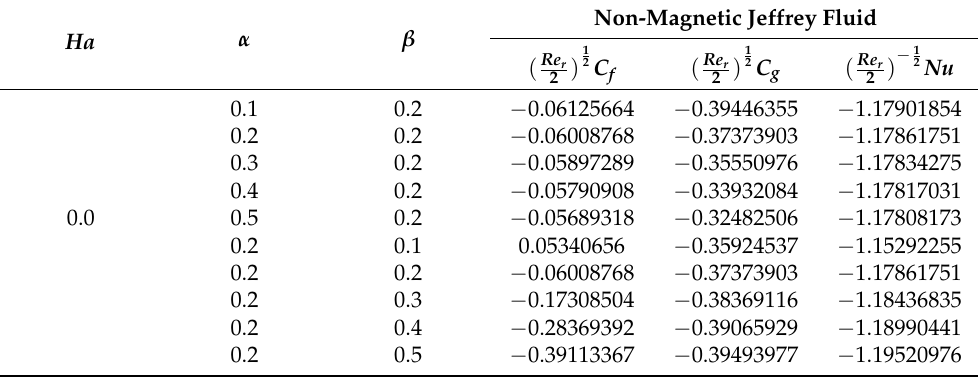
1 1 ) ) ( Re r 2 C 2 C g , and ( Re r f , 2 2